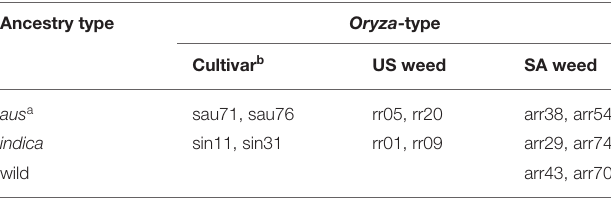
TABLE 1 | Oryza genotypes included in the study and their ancestry and Oryza -type groupings. Ancestry